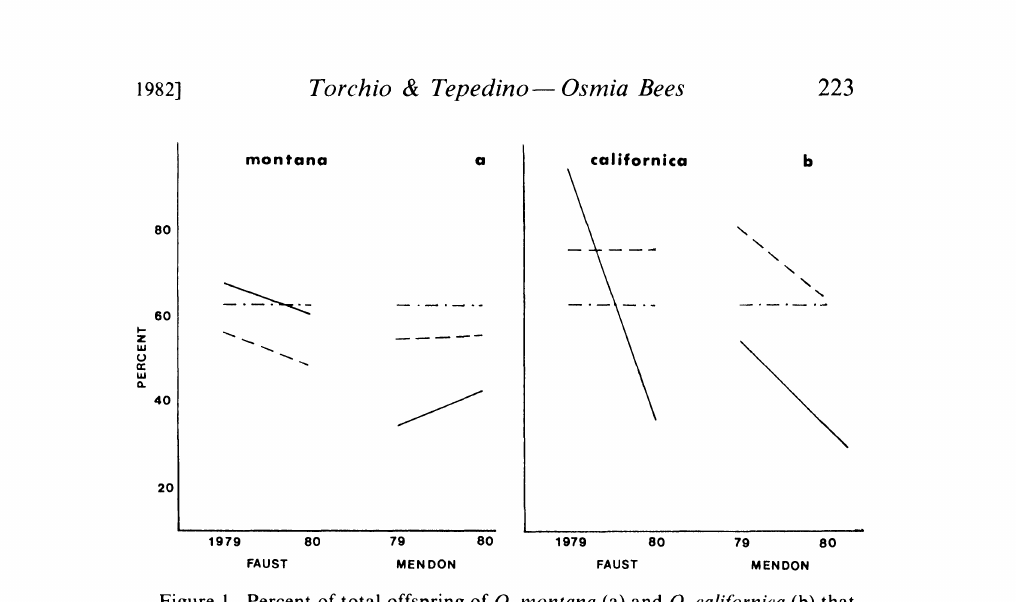
Figure I. Percent of total offspring of O. montana (a) and O. cal(fornica (b) that were one-year forms (solid lines), and males (dashed line) at two northern Utah sites over two years. Dotted and dashed line represents the expected sex ratio as percent